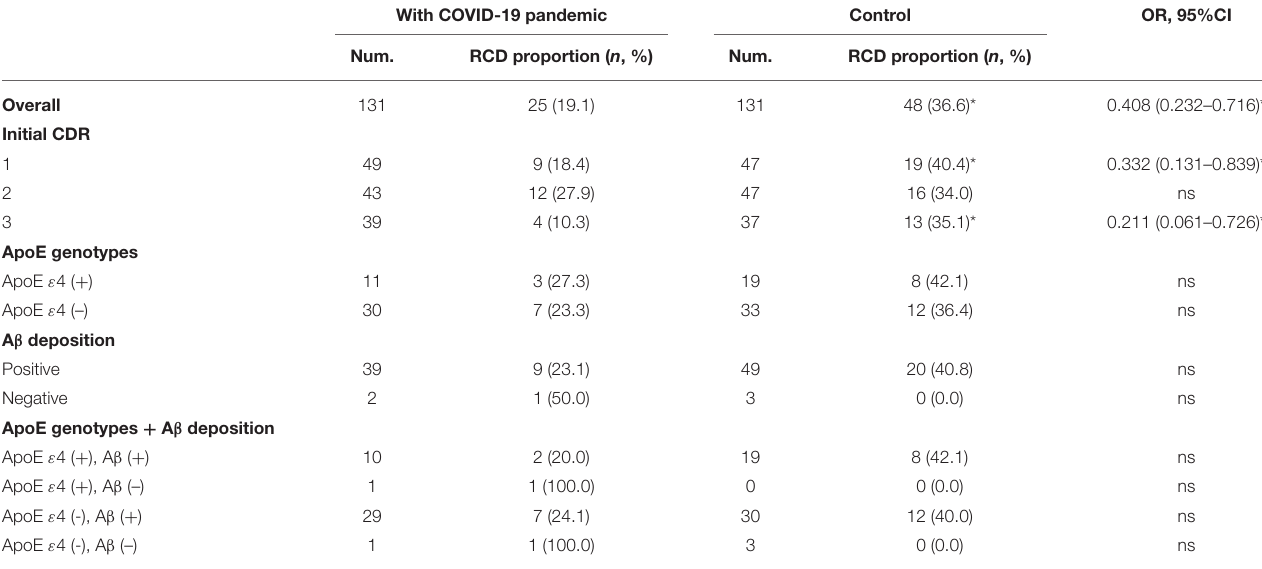
TABLE 3 | Proportions of RCD in AD patients at the follow-up. With COVID-19 pandemic